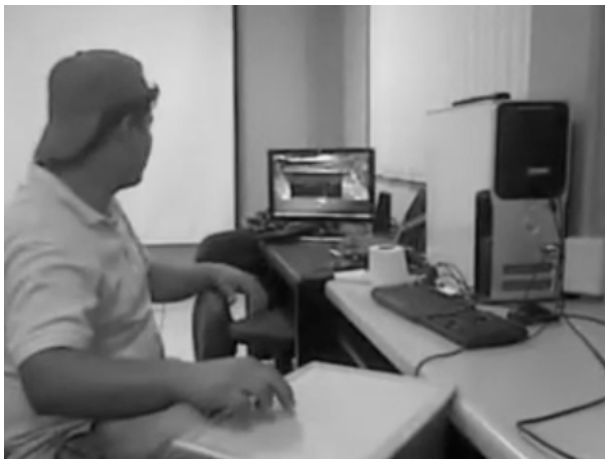
Figure 2. The students create the interacting devices. The image illustrates a gesture interaction.